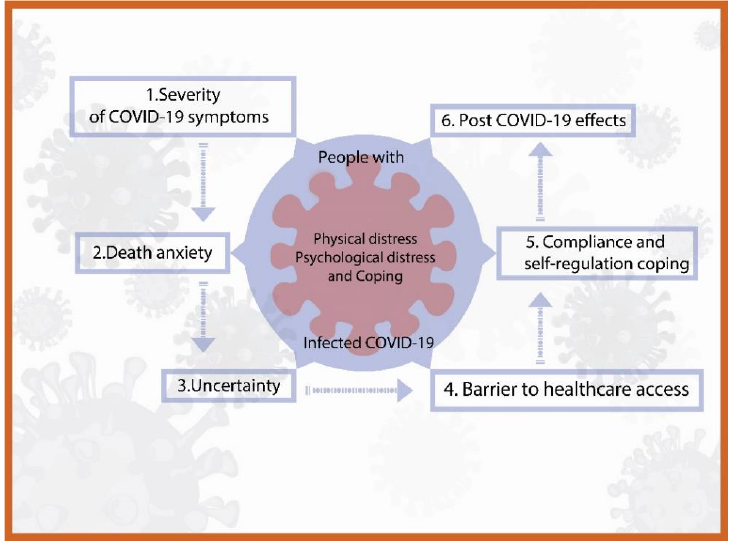
Figure 2. A grounded theory framework: physical, psychological distress, and coping among people infected with COVID-19.